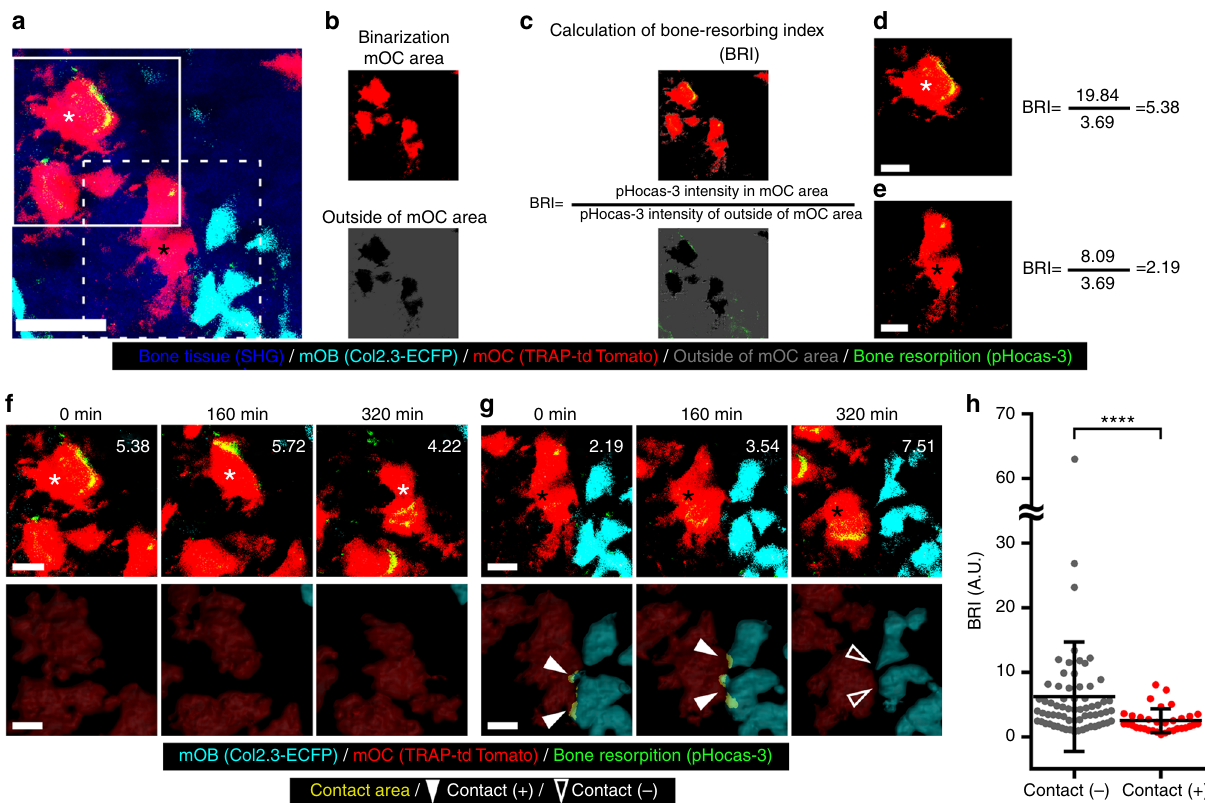
Fig. 2 Direct contact with mOBs inhibits the bone-resorbing activity of mOCs. a A representative MIP image of bone-resorptive activity in skull bone tissue of a Col2.3-ECFP/TRAP-tdTomato mouse injected with a pH-sensing chemical probe, pHocas-3. Green, pHocas-3; cyan, mOBs expressing Col2.3-ECFP; red, mOCs expressing TRAP-tdTomato; blue, bone tissues (SHG). Scale bar, 50 µ m. b , c Assessment of mOC bone-resorbing activity. b Areas containing mOCs were automatically binarized from the original images. Red, mOC areas; gray, regions outside the mOC areas. c Mean pHocas-3 fl uorescence intensities were measured inside (pHocas-3 signal) and outside the mOC areas (pHocas-3 noise). The bone resorbing index (BRI) was the ratio of the pHocas-3 signal to the pHocas-3 noise. d , e Images processed for BRI calculations ( d for the mOC indicated with white asterisk in the outlined region of a , and e for the mOC indicated with black asterisk in the region delineated with a dotted line in a ). Scale bar, 20 µ m. f , g Magni fi ed MIP images from the region outlined in a and f , and the region delineated by the dotted line in a and g , captured at 0, 160, and 320 min (upper panels). The 3D images yielded by colocalization analysis (bottom panels). Scale bar, 20 µ m. The contact areas were those where mOBs and mOCs colocalized and are shown in yellow. The fi lled arrowheads show areas of mOB – mOC contact. The open arrowheads indicate separated mOBs and mOCs. The actual BRI values are shown to the right of the images. h BRI of mOCs in contact, or not, with mOBs. Snapshot MIP images were collected from 14 independent experiments; n = 34 (mOCs in contact with mOBs), n = 67 (mOCs not in such contact). Data are presented as means ± SDs. **** p < 0.0001 (Mann – Whitney